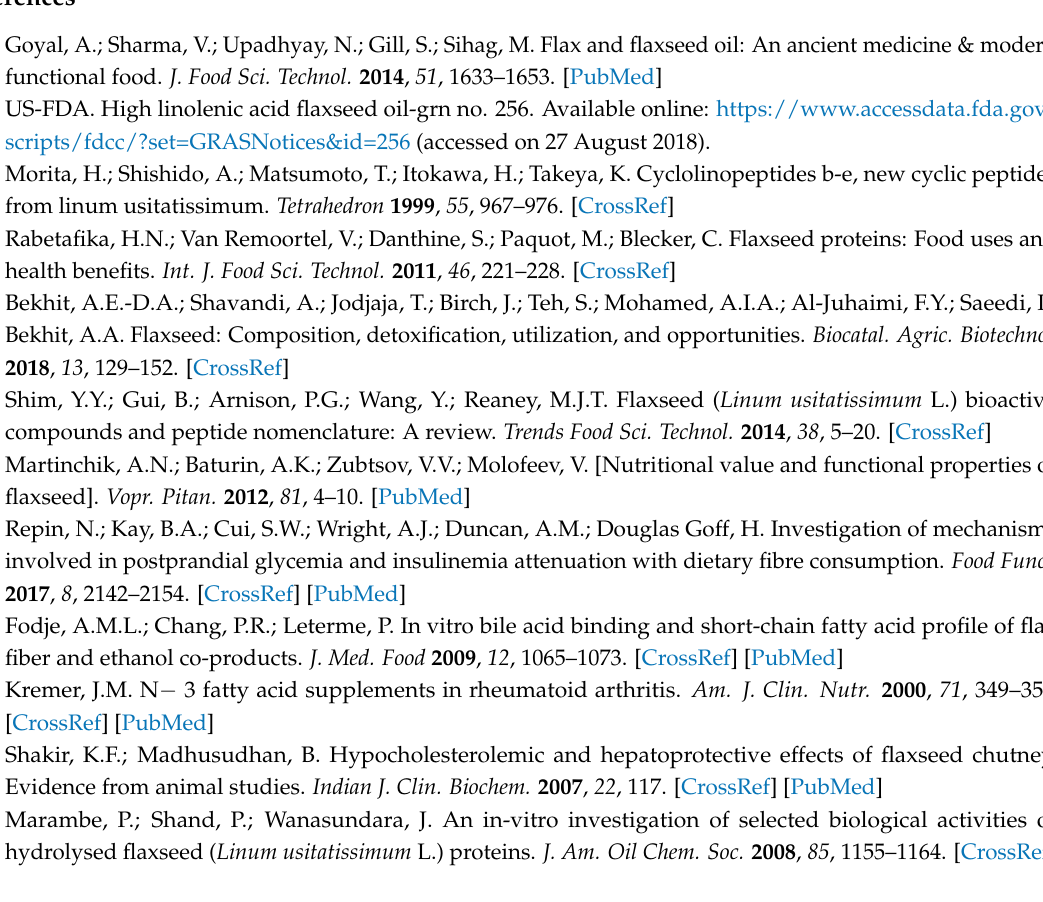
Supplementary Materials: An interactive and comprehensive version of Figure 1 is available at this link: https://dl.dropboxusercontent.com/s/5o729rqawjuci5s/Krona%20for%20composition.html?dl=0. Readers are encouraged to download this html file onto a local drive before